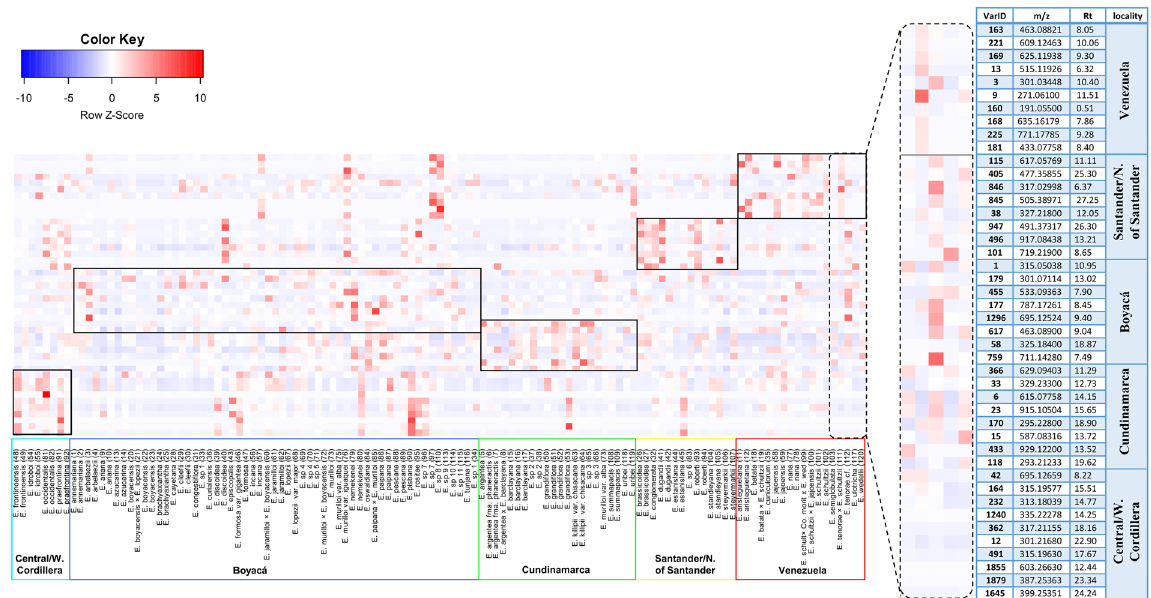
Figure 5. Heatmap based on metabolic fingerprinting in negative ionization mode of 120 plant samples of the genus Espeletia analyzed by UHPLC-UV-HRMS, showing the differential accumulation of the top ranked OPLS-DA mass features (right box) according to each geographic locality (for compound identities see Table